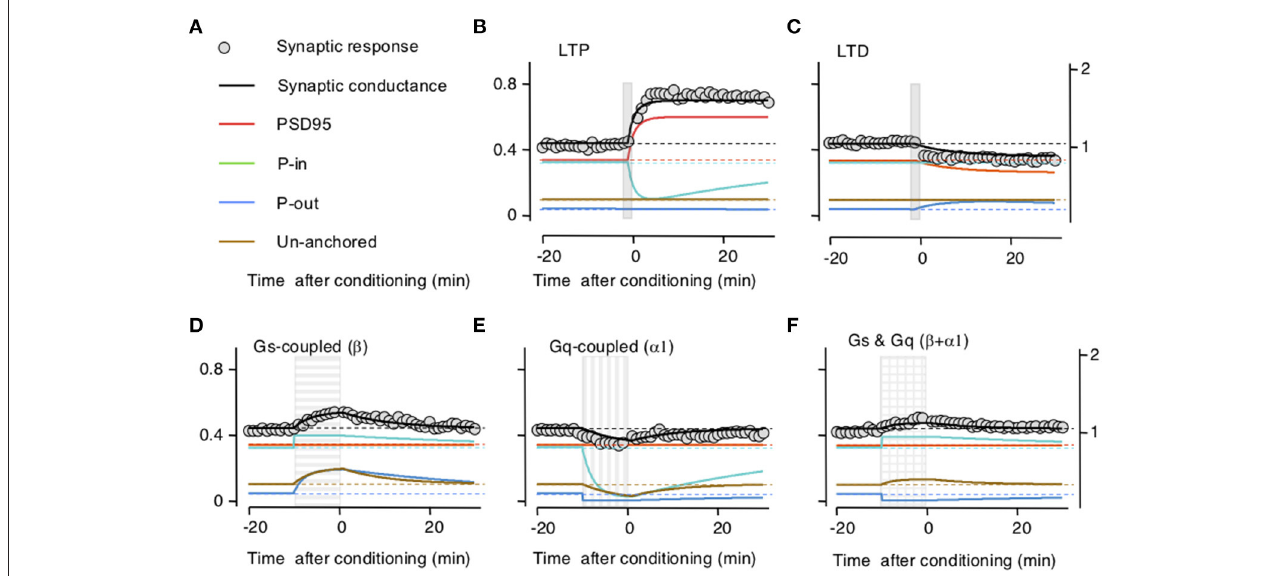
FIGURE 2 | Simulation of how long-term potentiation (LTP)/long-term depression (LTD) induction and the stimulation of Gs and Gq-coupled receptors change the occupancy of the modeled AMPA receptor (AMPAR) compartments. (A) Color conventions of the various synaptic compartment described in the remaining panels. Also included are gray circles representing actual synaptic response data from Huang et al. (2012). (B) An LTP-induction protocol (vertical gray bar) transiently increases AMPAR traffic onto the postsynaptic density compartment (PSD)95 from the PeriIN compartment, depleting it, but without affecting the PeriOut compartment. This results in a net increase in synaptic conductance with a time course, comparable with changes reported in Huang et al. (2012). Left Y -axis: occupancy of synaptic compartments; right Y -axis: normalized synaptic response. (C) An LTD protocol (vertical gray bar) transiently increases traffic out of the PSP onto the PeriOut compartment, filling it up, and reducing synaptic conductance. (D) Stimulation of Gs-coupled receptors (horizontally striped bar) increases AMPAR trafficking from the endosomatic compartment into all but the PSD synaptic compartments causing a transient increase in synaptic conductance. (E) Stimulation of Gq-coupled receptors (vertically striped bar) increases AMPAR trafficking to the endosomatic compartment from all but the P synaptic compartments causing a transient decrease in synaptic conductance compartments. (F) Stimulation of Gs-and Gq-coupled receptors (checkered bar) increases AMPAR trafficking (in and out) between the endosomal and all but the PDS95 synaptic compartments. This fills up the PeriIN compartment, depletes the PeriOut compartment, and results in a modest transient increase in synaptic conductance.